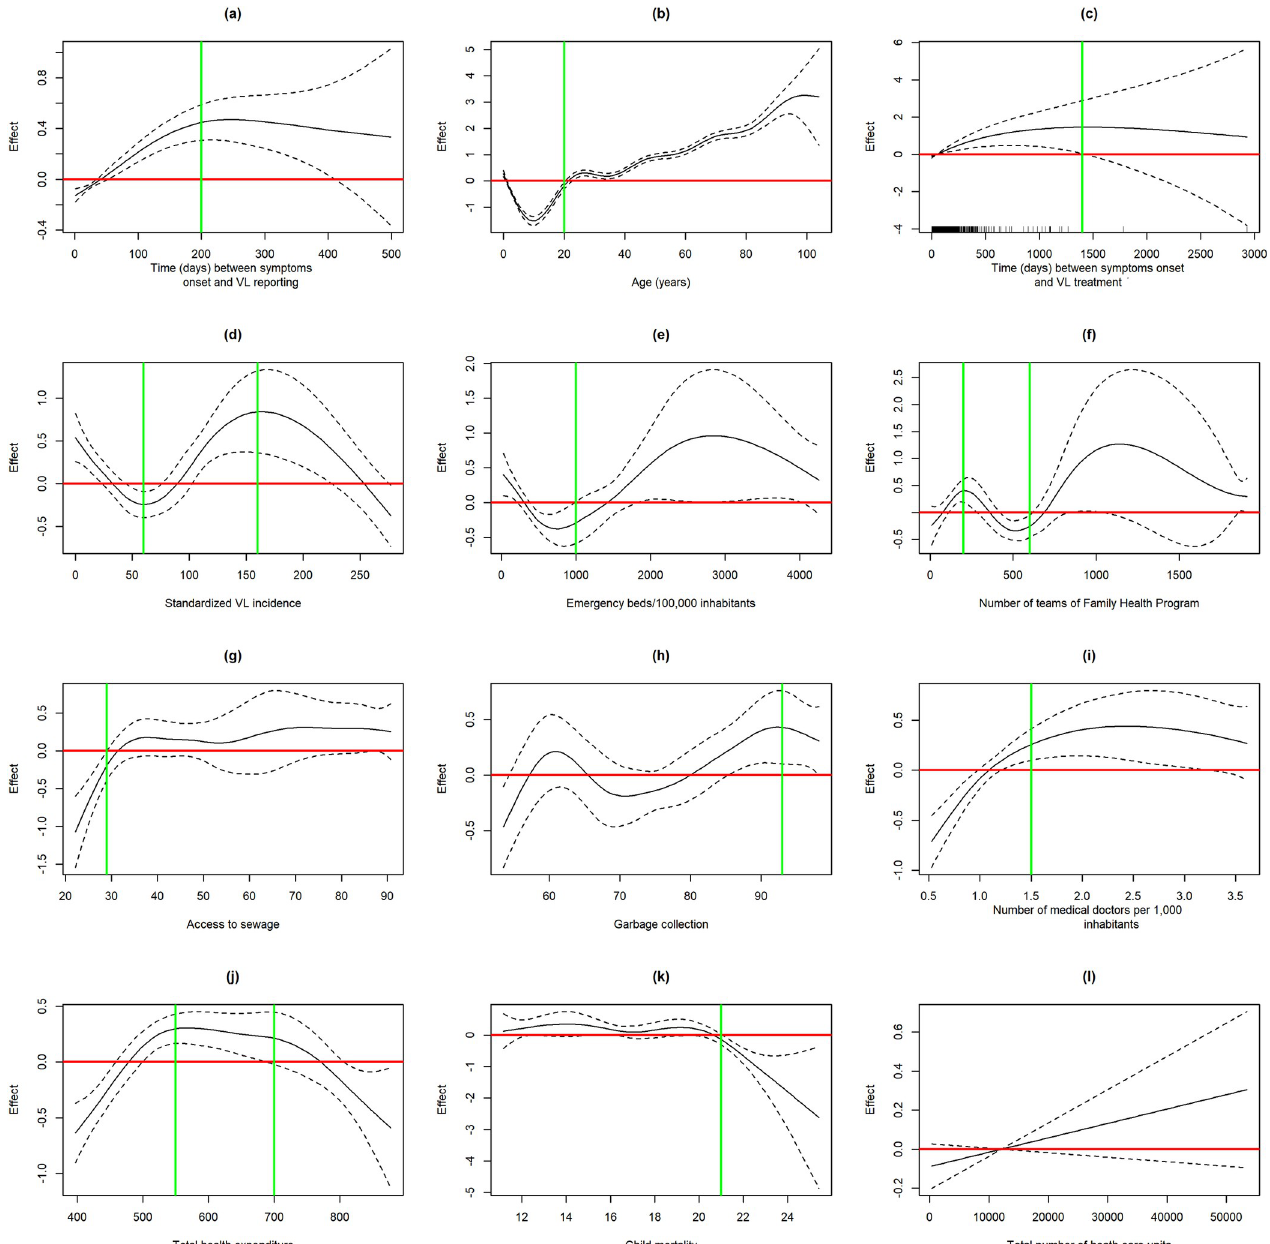
Fig 5. Effect of continuous variables on VL case-fatality (GAMM